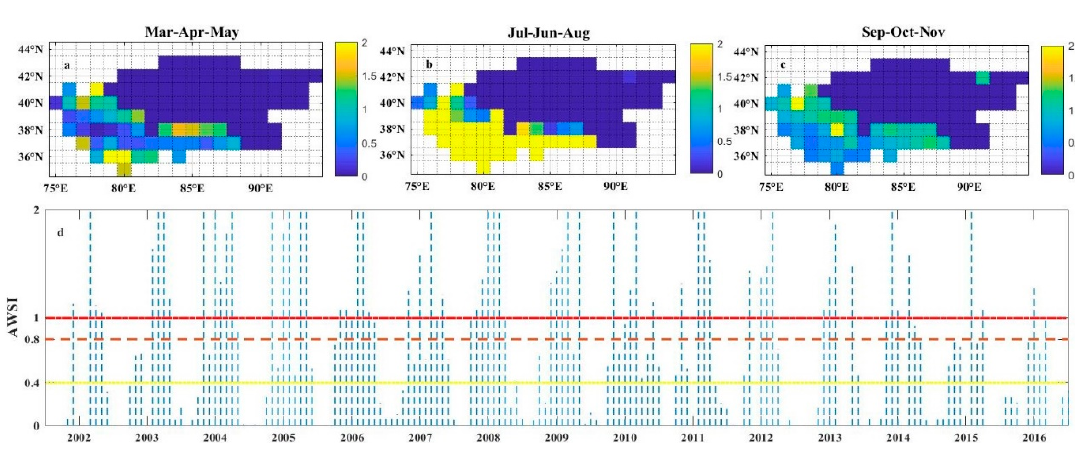
Figure 2. The spatial and temporal pattern of the agricultural water stress index (AWSI) over the region between 2002 and 2016. (( a – c ) are spring, summer, and autumn AWSI patterns, respectively; ( d ) is the monthly average change trend of AWSI).